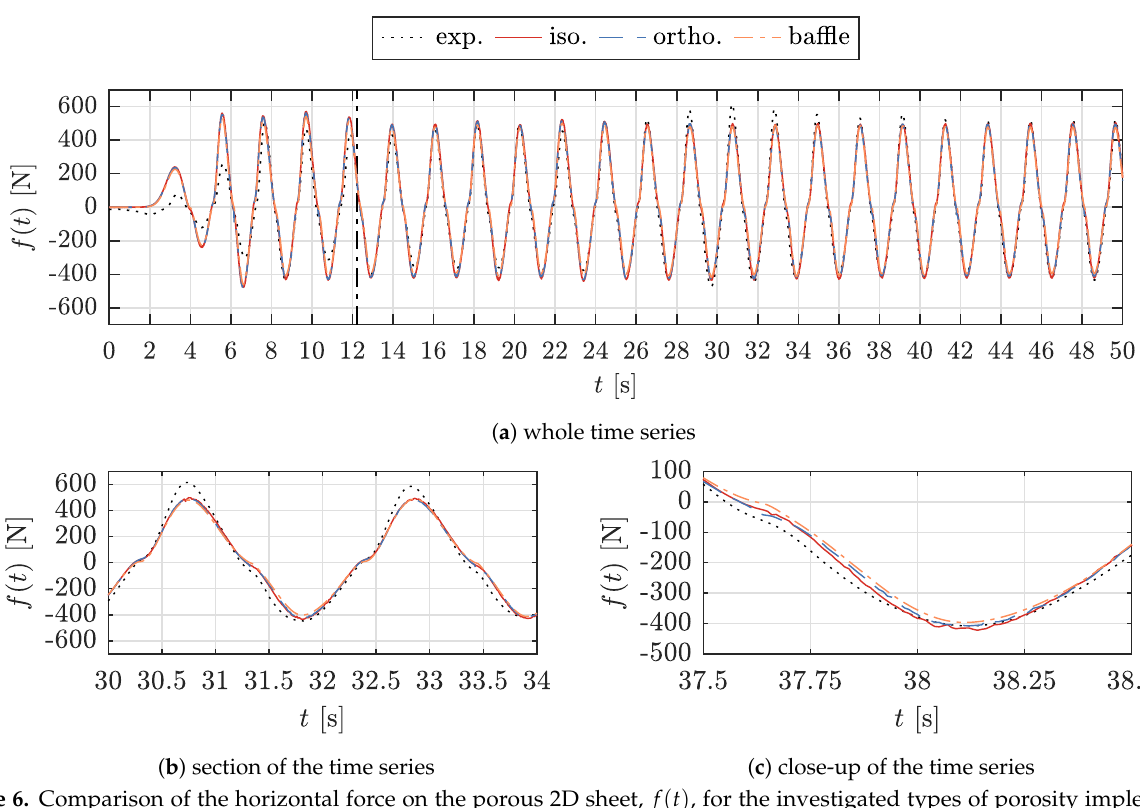
Figure 6. Comparison of the horizontal force on the porous 2D sheet, f ( t ) , for the investigated types of porosity implementation. ( a ) whole time series ( b ) section of the time series ( c ) close-up of the time